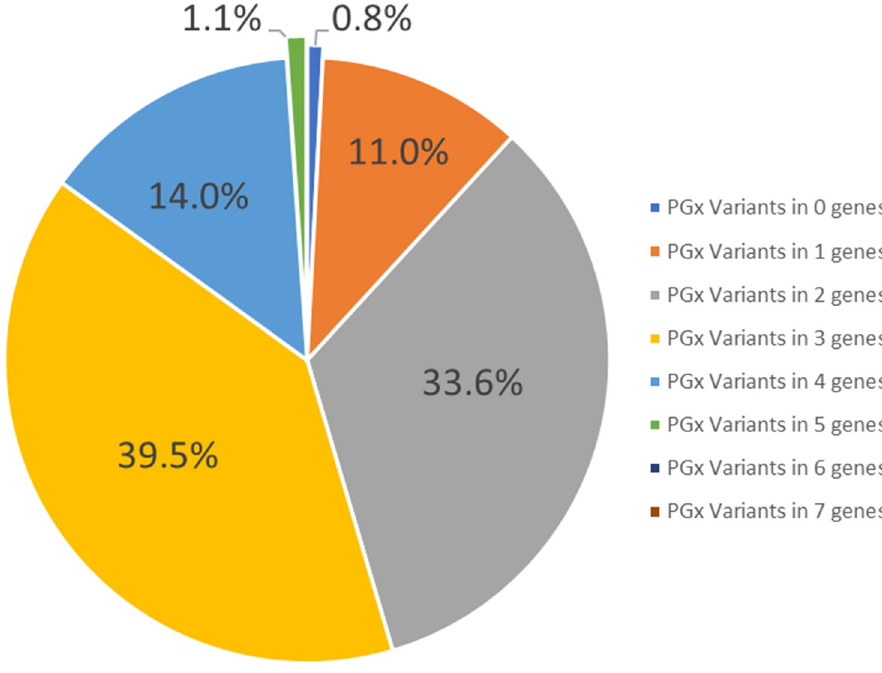
Fig 3. Percentage of Saudi subjects carrying actionable variants in zero to five pharmacogenomics genes.